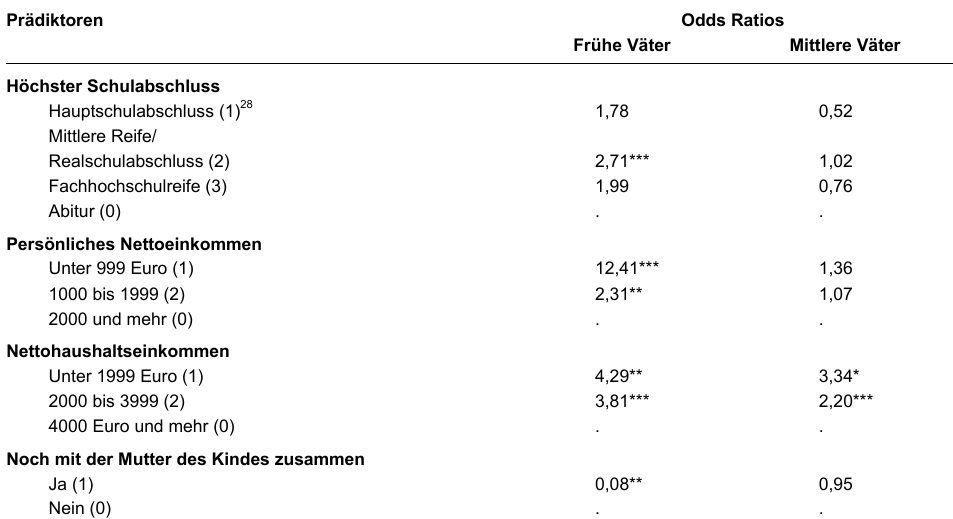
Frühe Väter Mittlere Väter